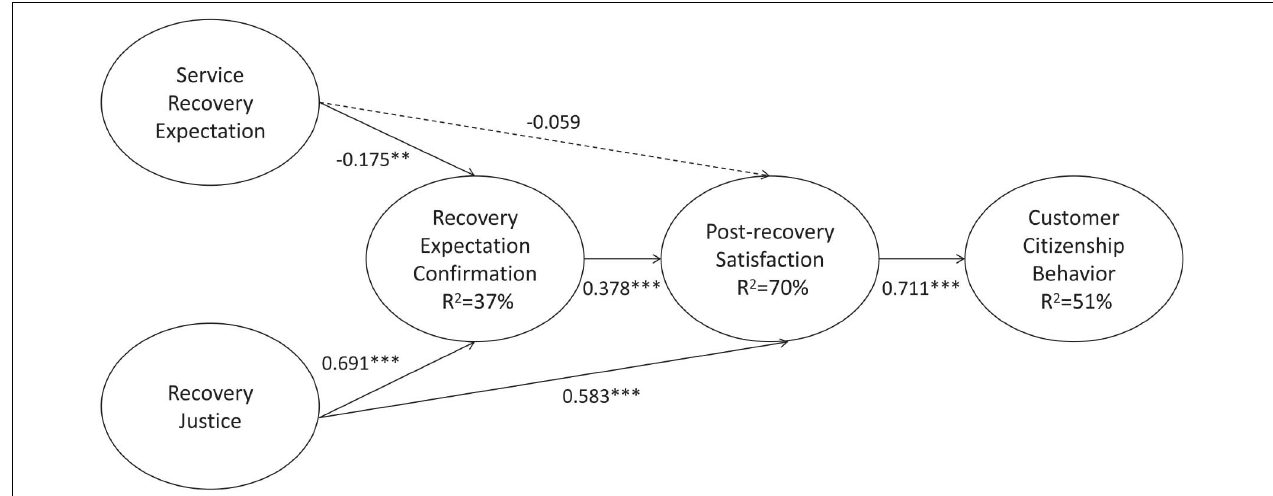
FIGURE 2 | Results of the hypothesized model (Based on the most impressive service recovery experience). ∗∗ p < 0.01, ∗∗∗ p < 0.001. → , supported path; (cid:57)(cid:57)(cid:75) , unsupported path.